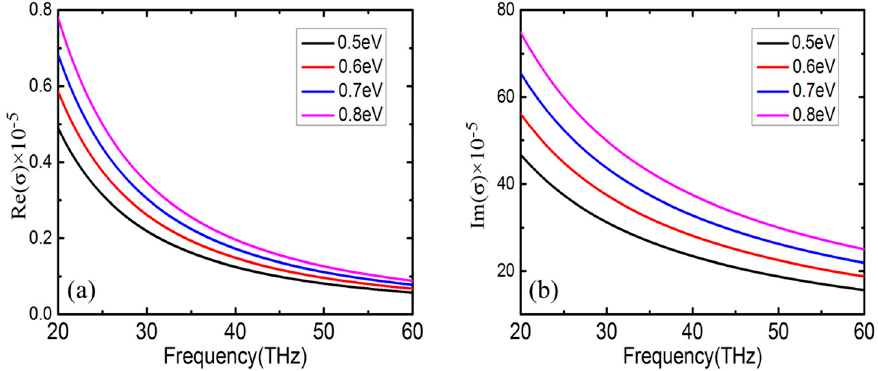
Figure 2. Diagram of graphene conductivity ( a ) real part ( b ) imaginary part at different Fermi levels.